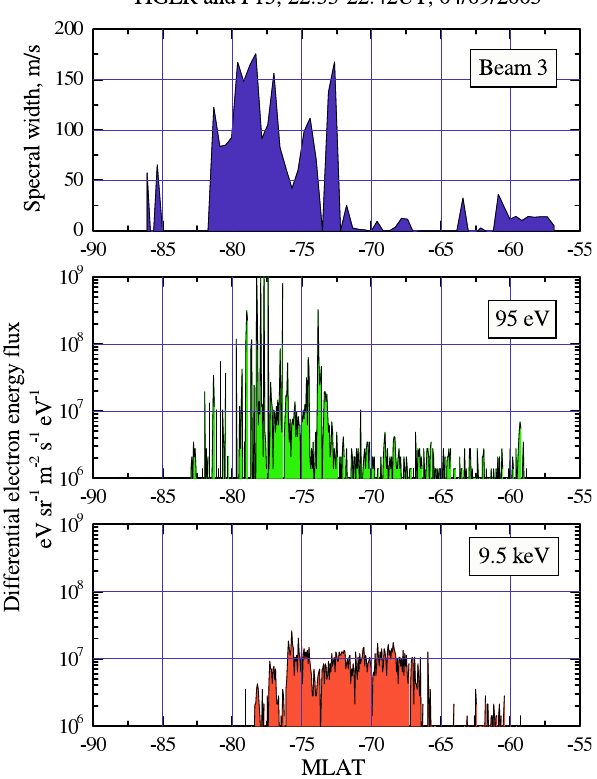
Fig. 12. Time series of DMSP15 differential electron flux and TIGER spectral width (beam 3) for data presented in Fig.